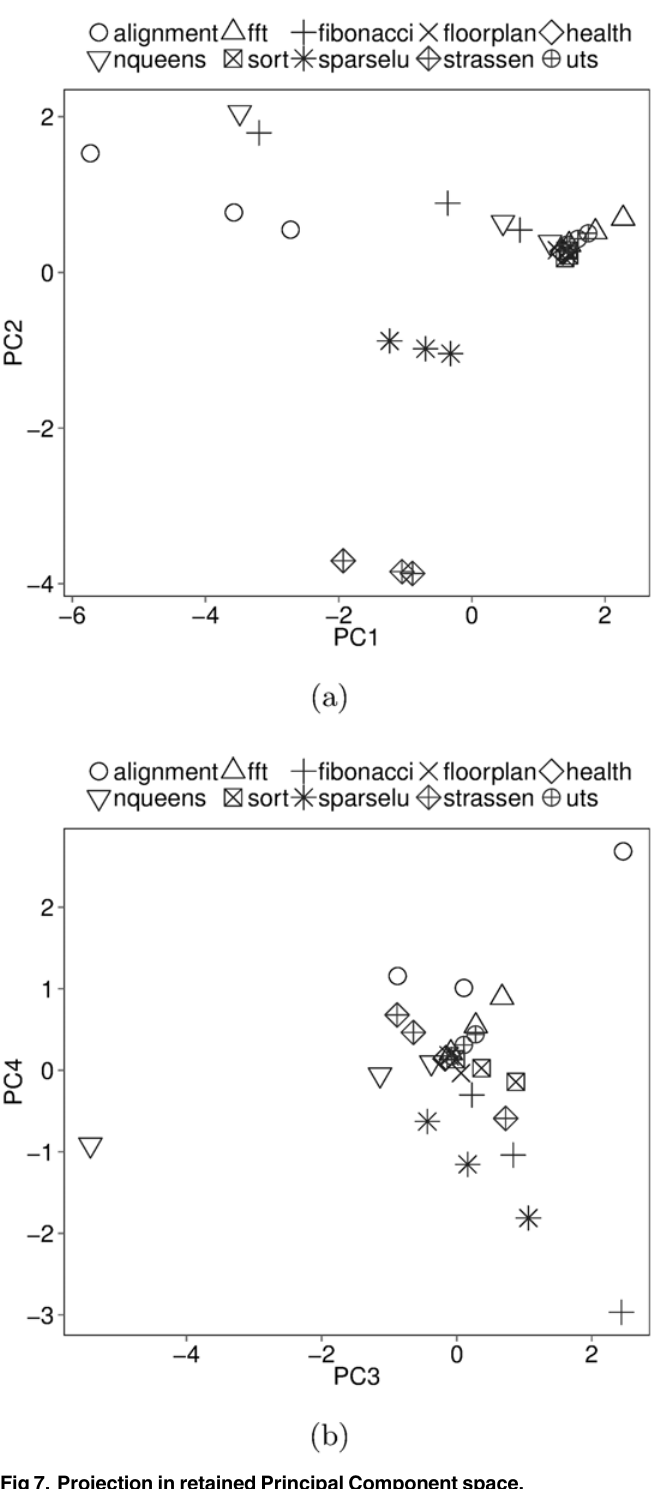
Fig 7. Projection in retained Principal Component